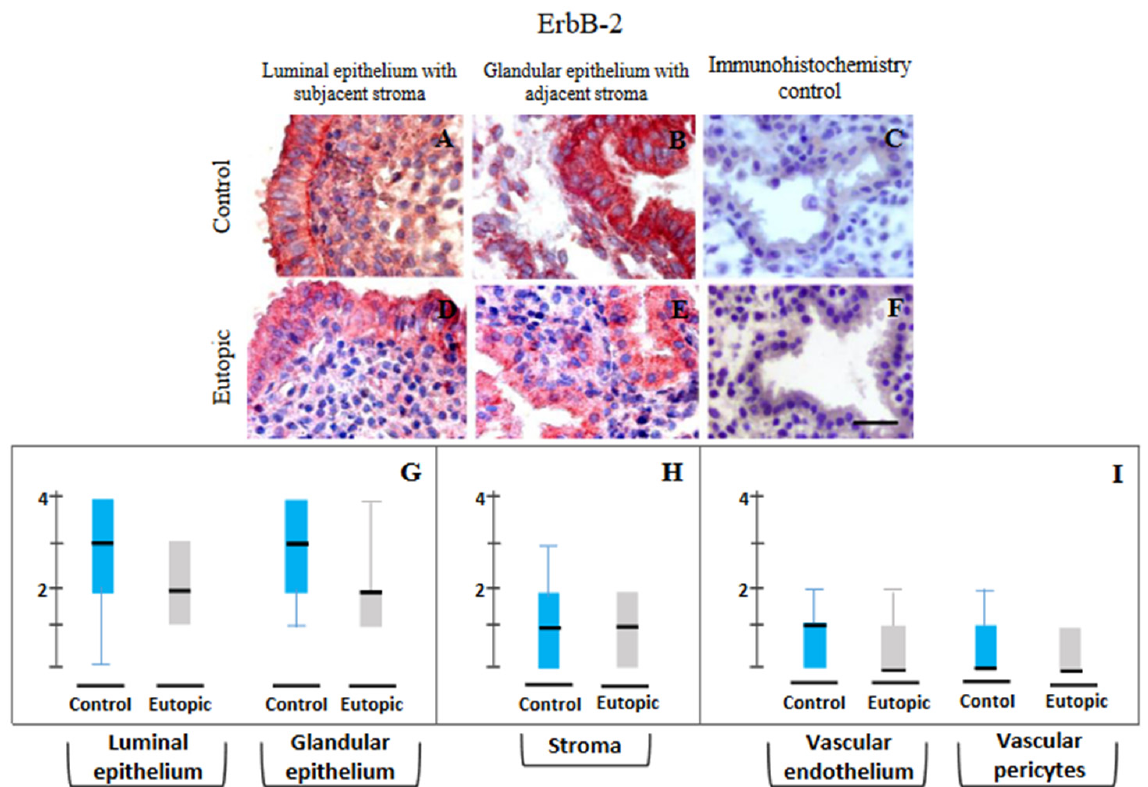
Figure 3. Representative photomicrographs of ErbB-2 ( A – F ) expressions in luminal epithelium along with subjacent stroma ( A , D ), glandular epithelium along with adjacent stroma ( B , E ) in endometrial samples collected from endometriosis-free control women of group 1 ( A – C ) and stage IV ovarian endometriosis patients of group 2 ( D – F ) and their semi-quantitative assessments shown in the form of box plots of 10–90 percentile distribution of scores, along with median values ( G – I ). No marked difference was observed in any compartment between the two groups. Controls for immunohisto- chemistry staining were attained by omitting the primary antibody ( C ) or the secondary antibody ( F ). Bar: 75 µ m. ErbB-4: Figure 5A–F documents the representative photomicrography of ErbB-4 immunopositivity in the epithelial and the stromal compartments of endometriosis-free control endometrium (Figure 4A,B) and eutopic endometrium from ovarian endometriosis patients (Figure 5D,E). Semi-quantitative scores of immunopositivity detected for ErbB-4 protein in endometrial samples (Figure 5G–I) obtained from control women (group 1) and patients with stage IV ovarian endometriosis (group 2) revealed only a marginally ( p < 0.05) higher trend of ErbB-4 immunopositivity in the glandular epithelium and stromal components of eutopic endometrium as compared to control endometrium (Figure